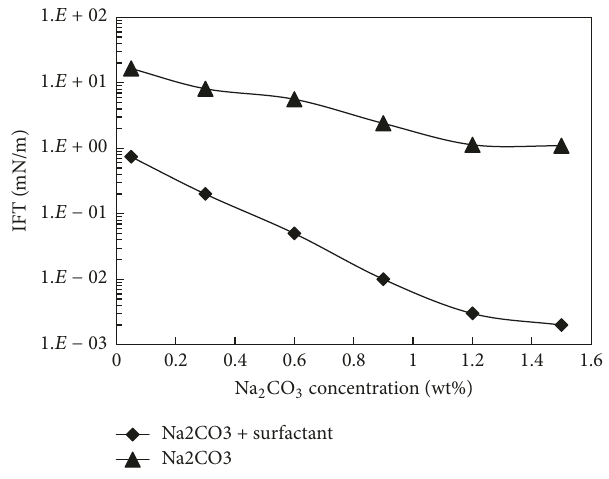
Figure 4: IFT between chemical solution and oil with different Na 2 CO 3 concentrations. The surfactant concentration is 0.065 wt%.